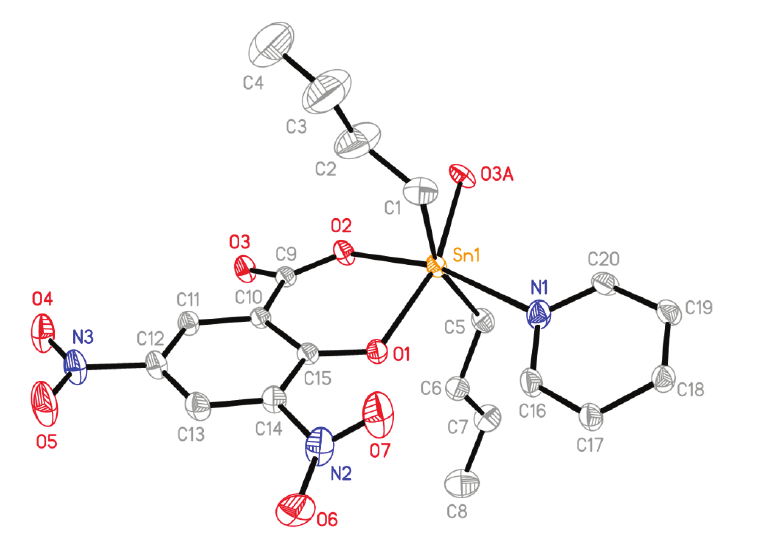
Figure 2: Perspective view of the asymmetric unit of compound 1 . Ellipsoids are drawn at the 30% probability level. Hydrogen atoms are omitted for clarity. Symmetry code A: – x + 1/2, y – 1/2, – z + 3/2.